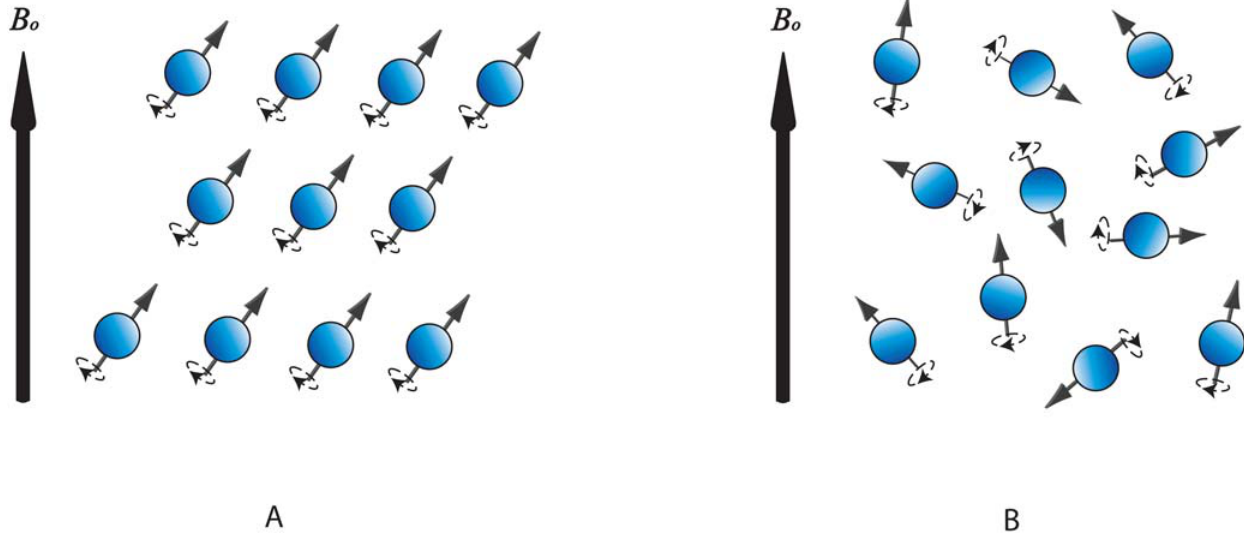
Figure 8. Nature of precessing blood proton spins. Hydrogen-based molecules in blood maintain coherent spin phases in static fluid (as shown in subfigure A), but are distributed chaotically in turbulent fluid and this disrupts the alignment of proton spins from their order (as illustrated by subfigure B). Due to the incoherent or random precession of spins, the net magnetization is weak and gives a low MR signal intensity. Therefore regions of blood at different levels of turbulence appear with contrasting pixel intensities in the cardiac MR image. The groups of incoherently precessing proton spins move along with the global blood flow within the cardiac chamber, and presence of intensity flow, which coincide with the blood flow, can be observed from time-dependent sequences of MR